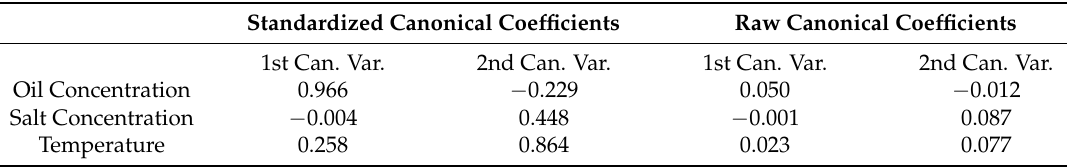
Table 3. Canonical variate coefficients of input set.